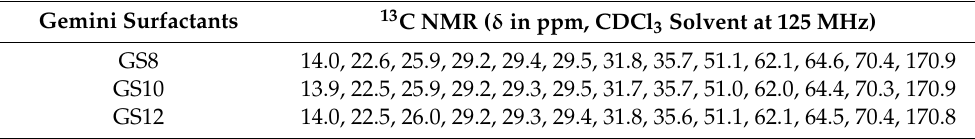
Table 2. 13 C NMR data describing the chemical shift values in